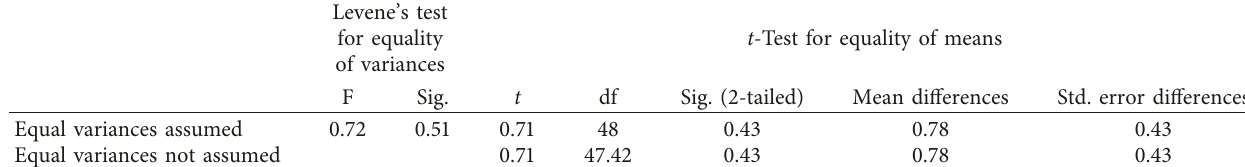
Table 7: Inferential statistics of the two groups on the motivation pretest.